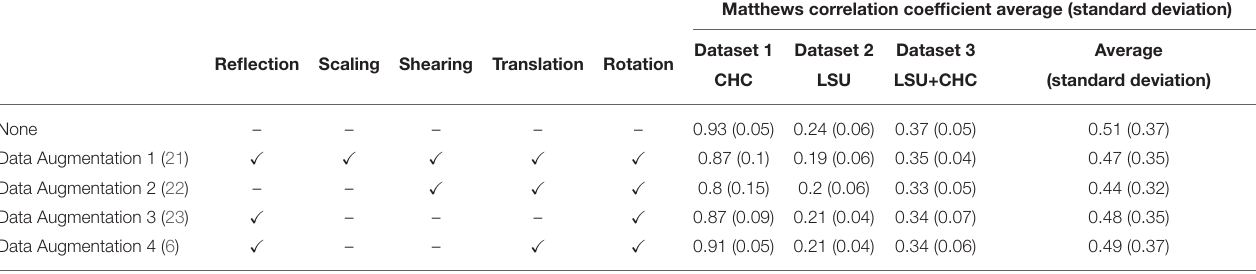
Matthews correlation coefficient average (standard